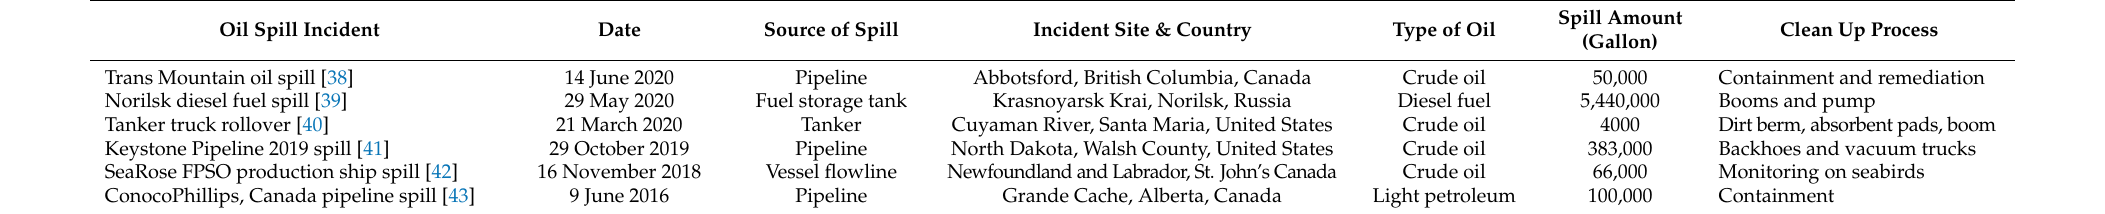
Table 6. List of oil spills incidents that occurred recently surrounding the Arctic